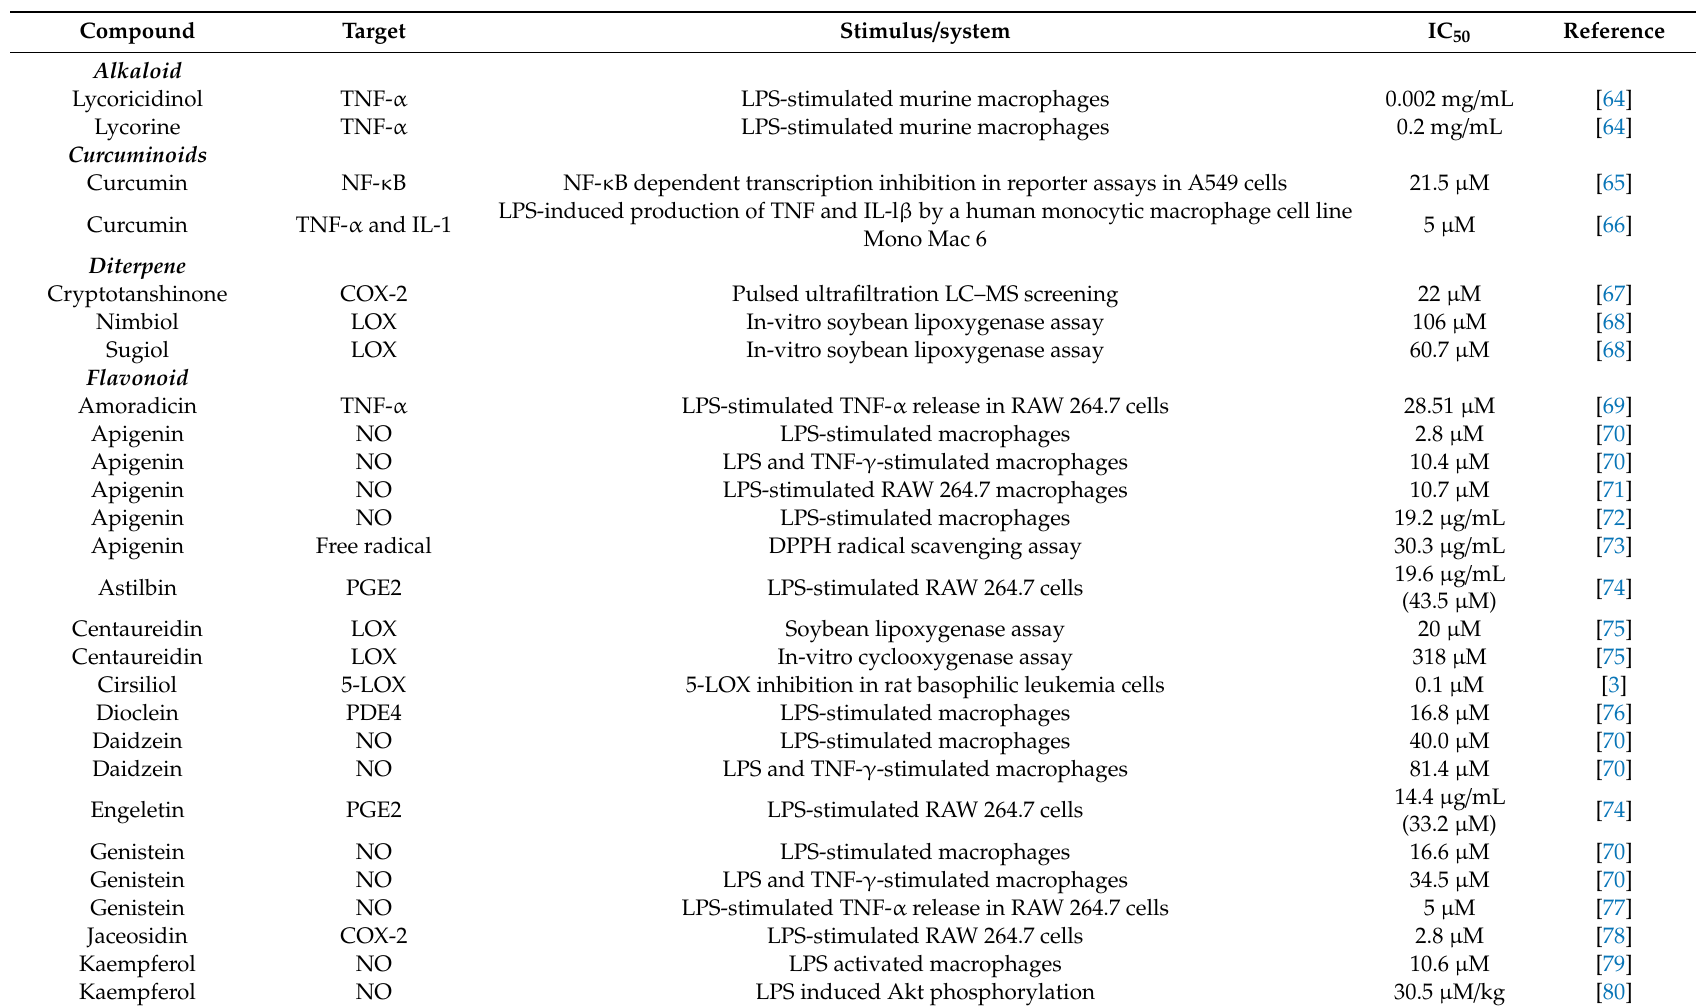
Table 2. IC 50 values of some phytoconstituents on various targets of